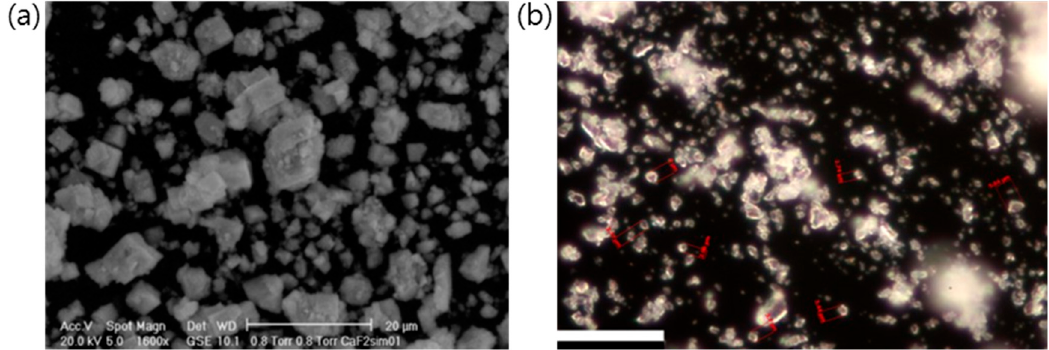
Figure 20. SEM images of the CaF 2 particle with the granulation method: ( a ) the ball milling method and ( b ) the mortar and pestle method [42].